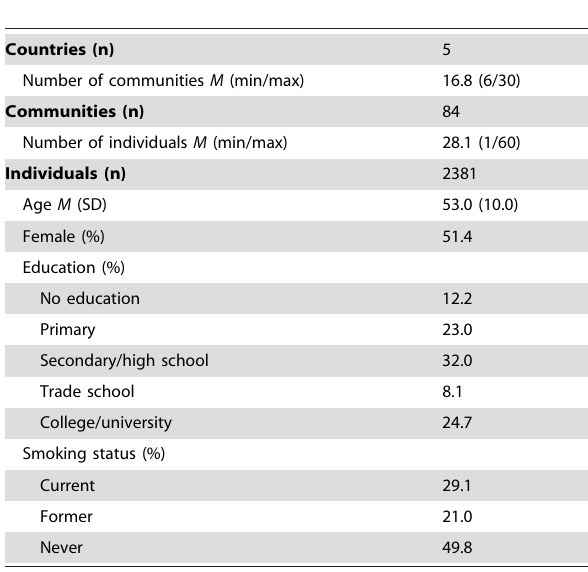
Table 1. Sample characteristics from the EPOCH 2 study in 5